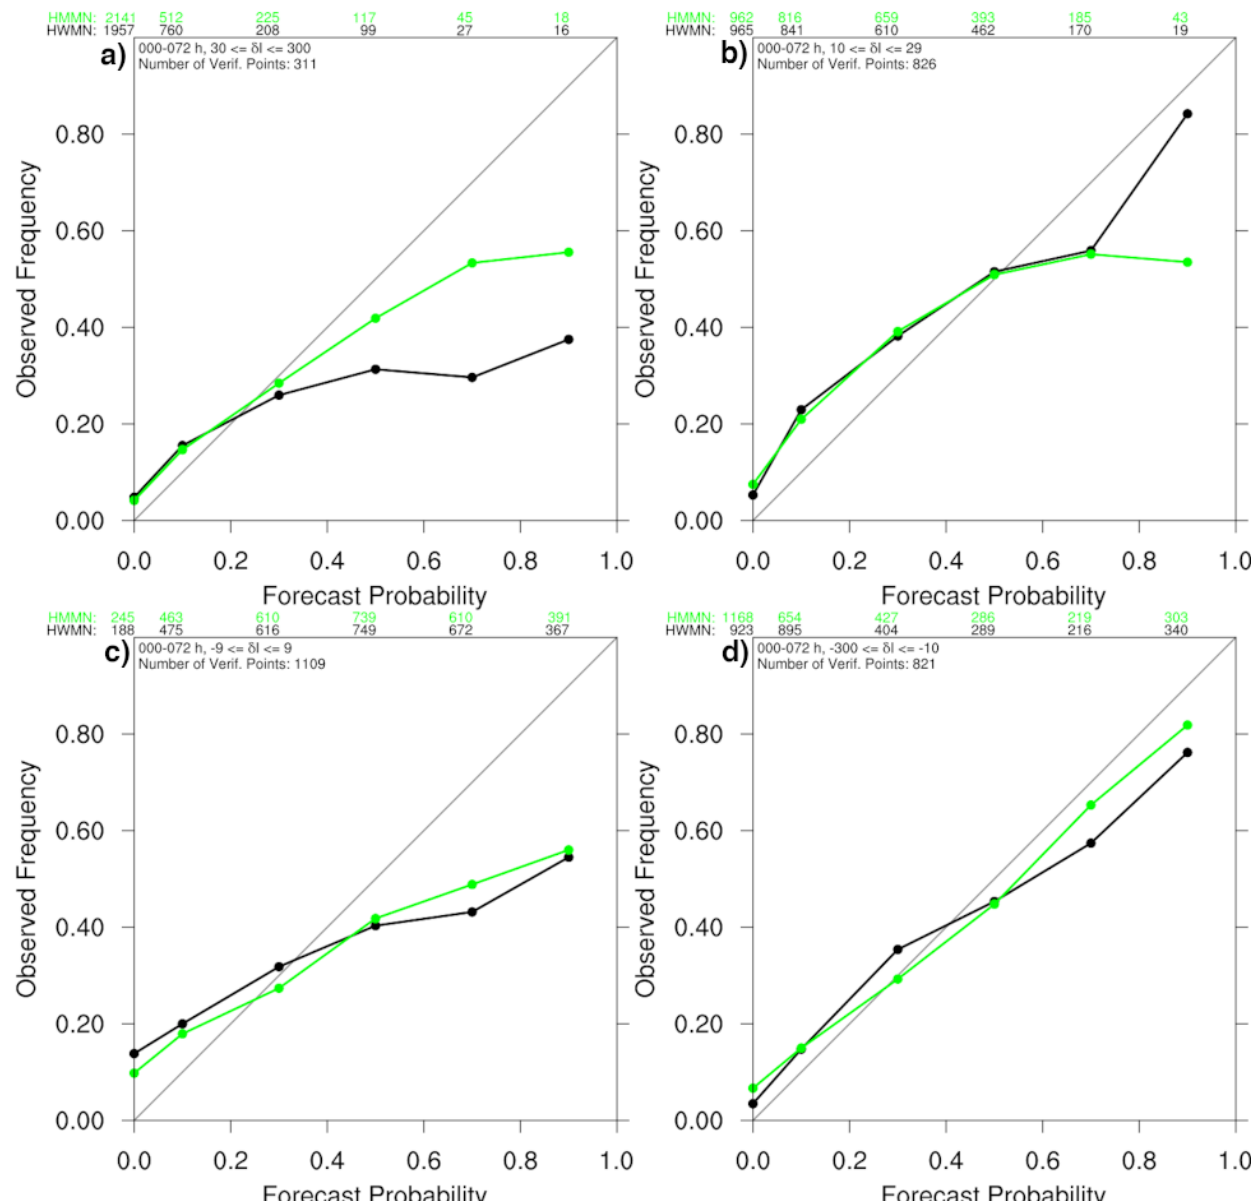
Figure 5. HWRF (black) and HMON ensemble (green) reliability diagrams for 24-h TC maximum wind speed change ( a ) >= 30 knots, ( b ) 10 <= δ I < 30 kts, ( c ) − 10 < δ I < 10 kts, and ( d ) δ I <= − 10 kts during each 24 h period from 0 to 24 h to 48–72 h during 2017–2019. The number of cases within each category is given along the top of each